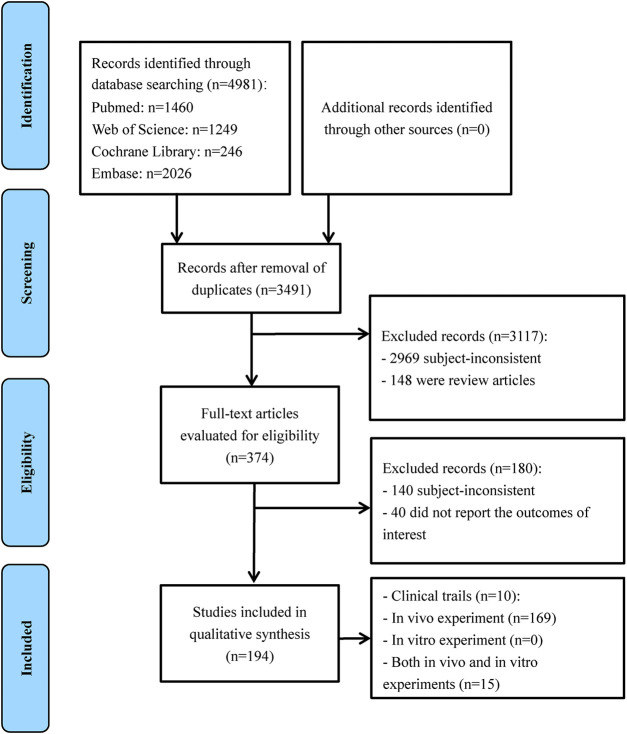
Flowchart of study selection for the systematic review.